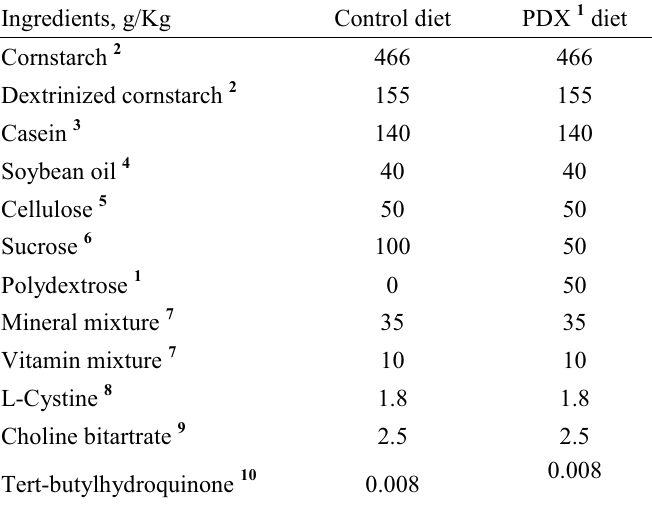
TABLE 1 - Composition of experimental